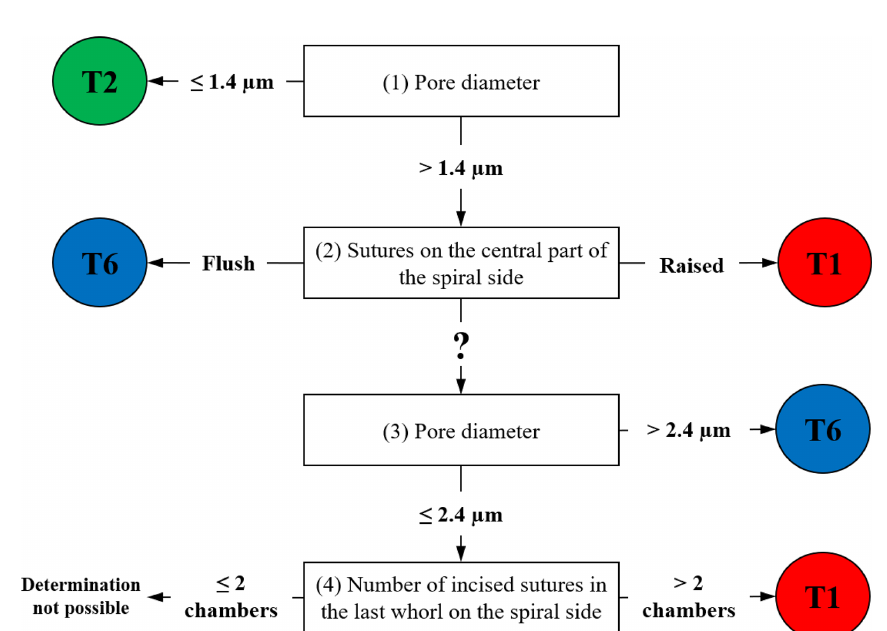
Figure 1. Dichotomous procedure to discriminate between T1, T2 and